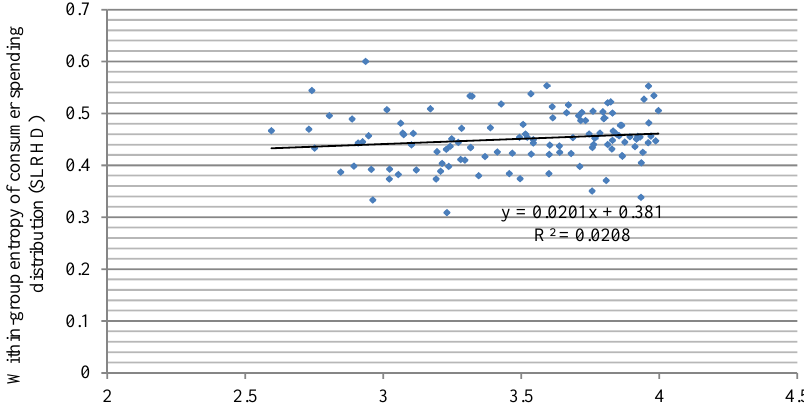
Figure 12. Linear regression for link "the absolute size of consumer spending — a measure of diversity of consumer spending (within-group entropy for SLRHD)" for 115 countries with lowest household spending